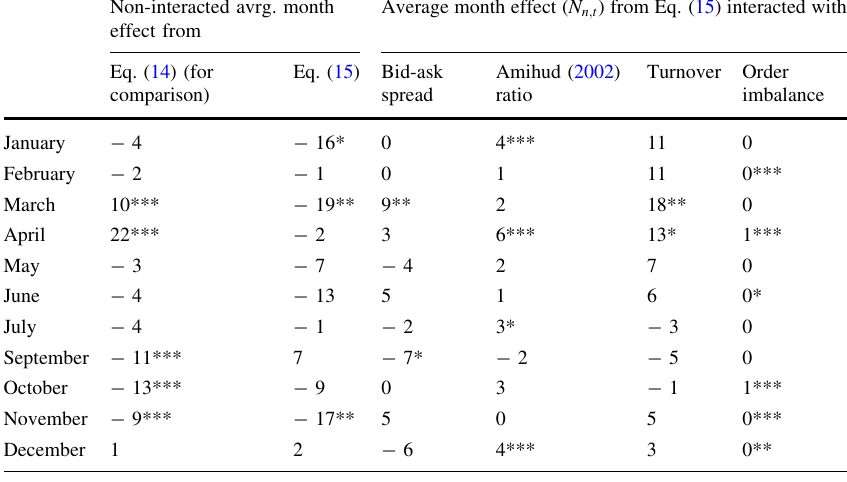
Table 8 Effects of liquidity and order imbalance on returns, part 5: Month effect Non-interacted avrg. month effect